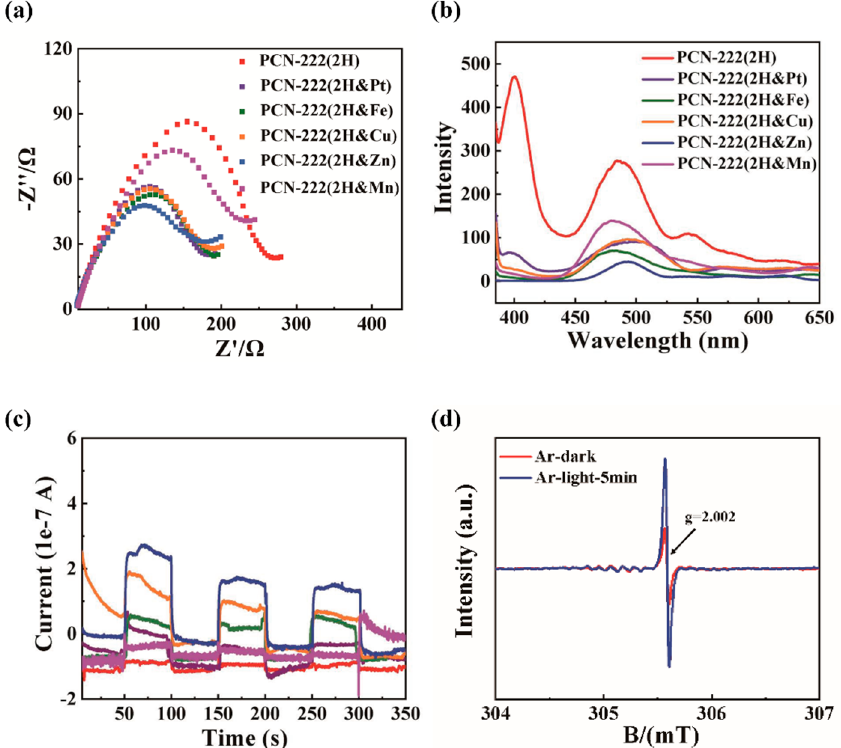
Figure 7. ( a ) EIS and ( b ) solid-state PL spectra excited at λ = 350 nm, ( c ) transient photocurrents of PCN − 222(2H) and PCN − 222(2H&M), and ( d ) EPR of PCN − 222(2H&Zn).